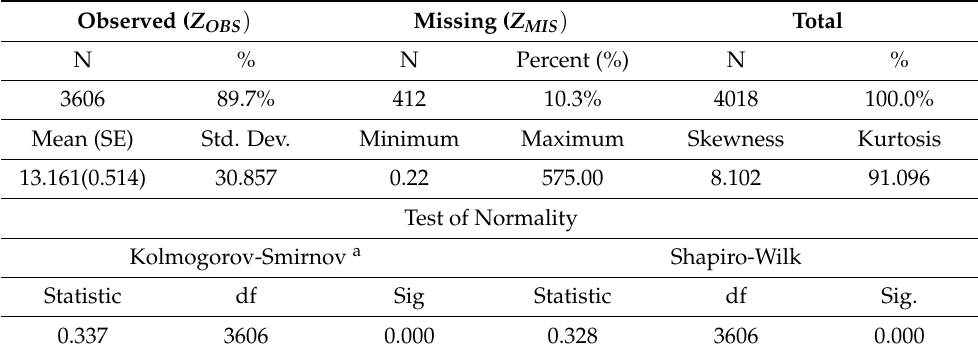
Table 5. Descriptive statistics and Normality test results of the transformed Maduwang catch- ment